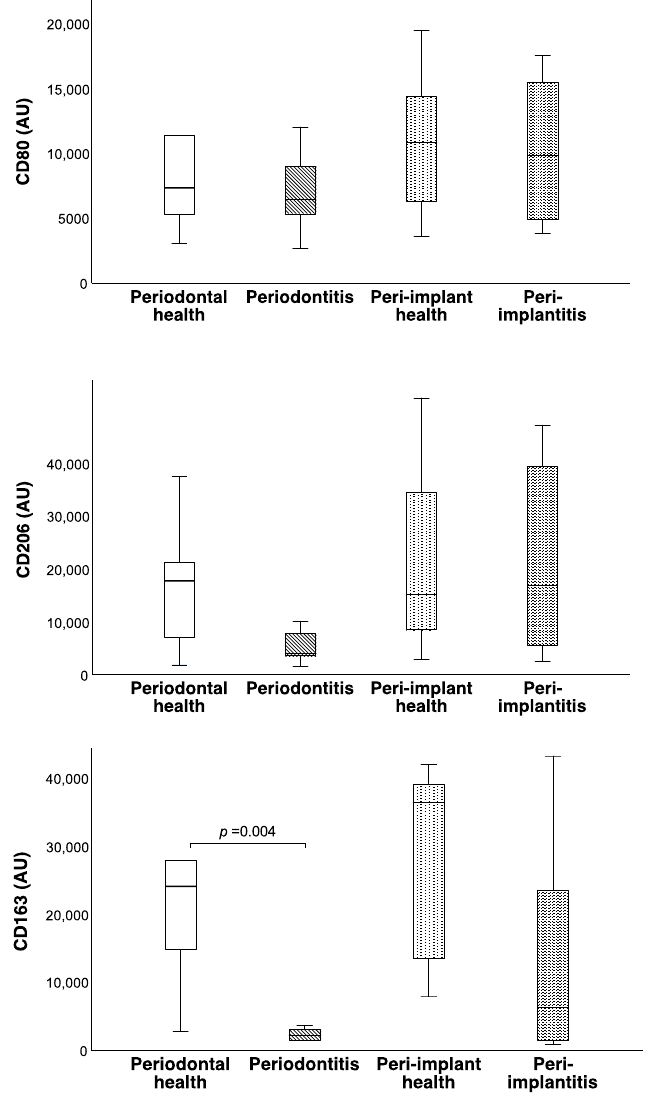
Figure 1. Box-and-whisker diagrams of arbitrary density units (AU) of CD80, CD163, and CD206 levels according to the groups. Multiple comparisons demonstrated statistically significant differences only in CD163 levels, while CD163 levels differed between the periodontitis and periodontally healthy groups but not between the peri-implantitis and peri-implant health groups. Horizontal lines represent the 25th, 50th, and 75th percentiles. p -value represents the statistical significance of pairwise comparisons.